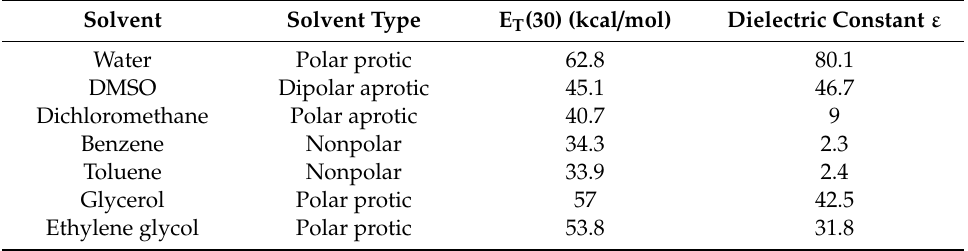
Table 2. Solvent properties